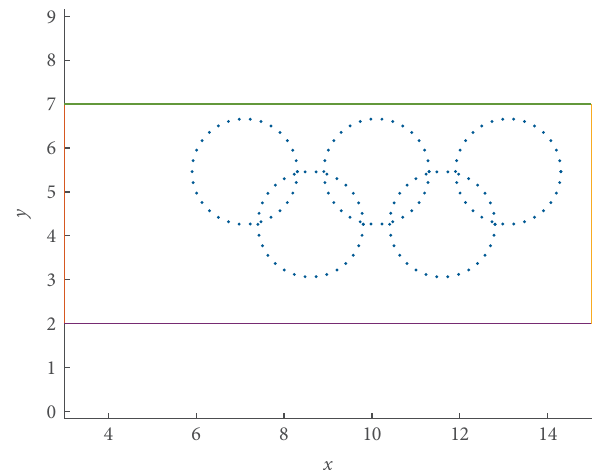
Figure 8: The final formation shape of a 155-agent.